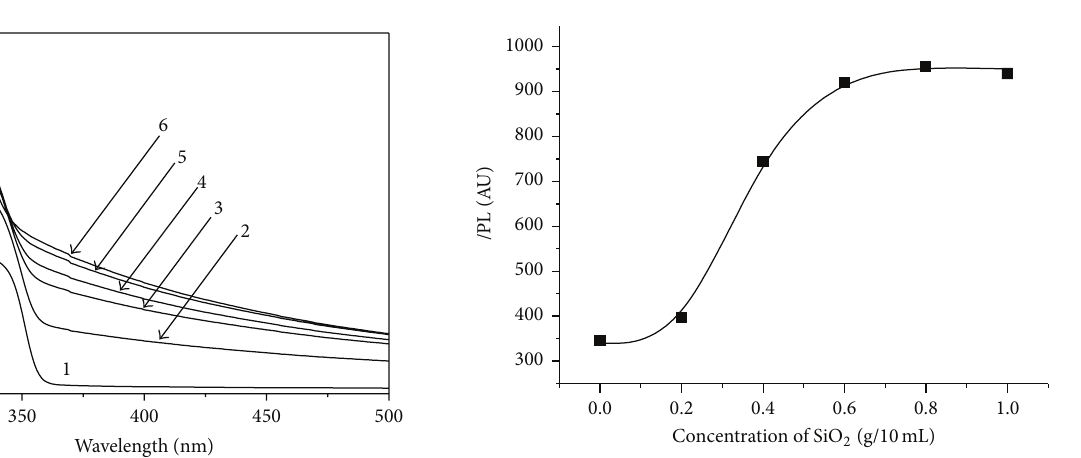
Figure 9: The absorption spectra of the colloidal solutions of ZnO nanoparticles without SiO 2 (1) and with provisionally adding 0.2 g (2), 0.4 g (3), 0.6 g (4), 0.8 g (5), and 1 g of silica (6) to 10mL of zinc oxide solution. [ZnO] = 2 × 10 −2 mol/L; 𝑙 = 0.1 cm.